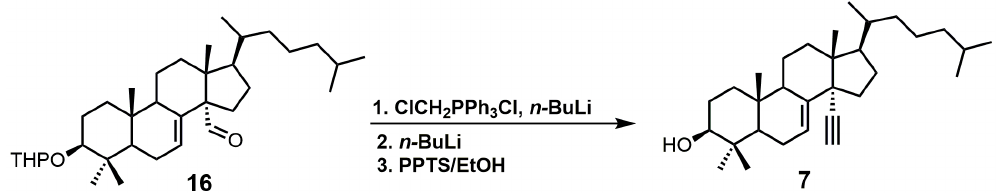
Figure 6. The synthesis of 4,4-dimethyl-14 α -ethynylcholest-7-en-30-ol ( 7 ).